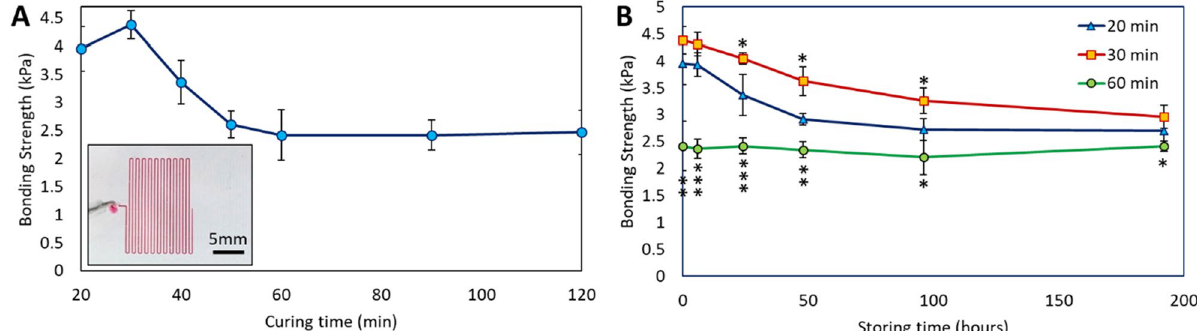
Figure 2. Characterization of PDMS/PS bonding. ( A ) Optimization of bonding strength by changing the PDMS curing time. Inset shows the microfluidic strategy used to evaluate the bonding strength. ( B ) PDMS/PS bonding strength by aging the PDMS microchip, having specific initial curing durations (20, 30 and 60 min). The results of statistical analysis of the bonding strength with 30 min baking compared to 20 min baking are shown above the 30 min graph, while the results comparing the 30 min and 60 min are shown below the 60 min graph (*P < 0.05, **P < 0.005) *P < 0.05, **P < 0.005, ***P <